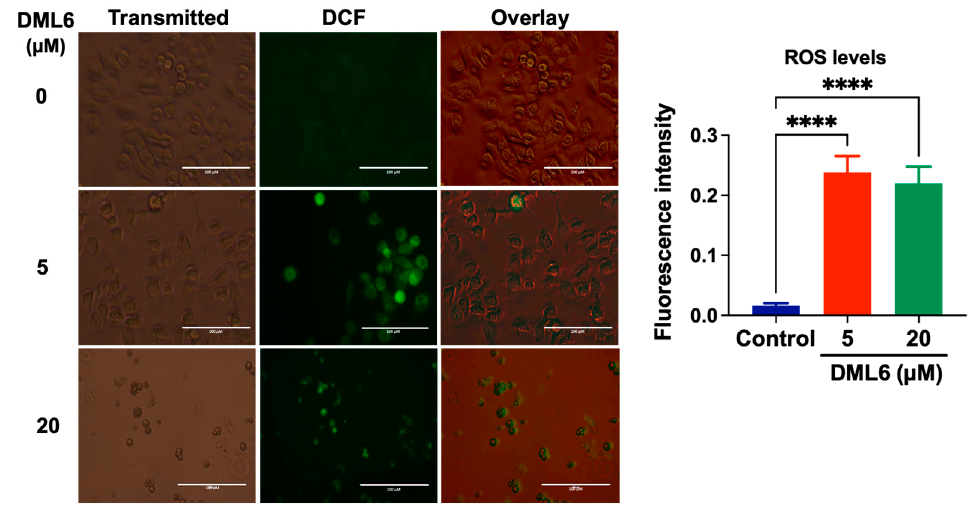
Figure 3. The detection of DML6 -induced cellular oxidative stress by DCF in OV2008 cells. Repre- sentative images of fluorescent DCFDA levels following incubation with the vehicle (control) (0 µ M), 5 or 20 µ M of DML6 for 24 h. The images were taken using an EVOS digital fluorescent microscope at 40 × magnification. A histogram quantitatively summarizing the change in the % of fluorescence intensity of DCFDA in cells incubated with 5 and 20 µ M of DML6 as compared to cells incubated with the vehicle, is also shown. **** p < 0.0001. The experiment was repeated in triplicate for each cell line. Scale bar: 100 μ M.